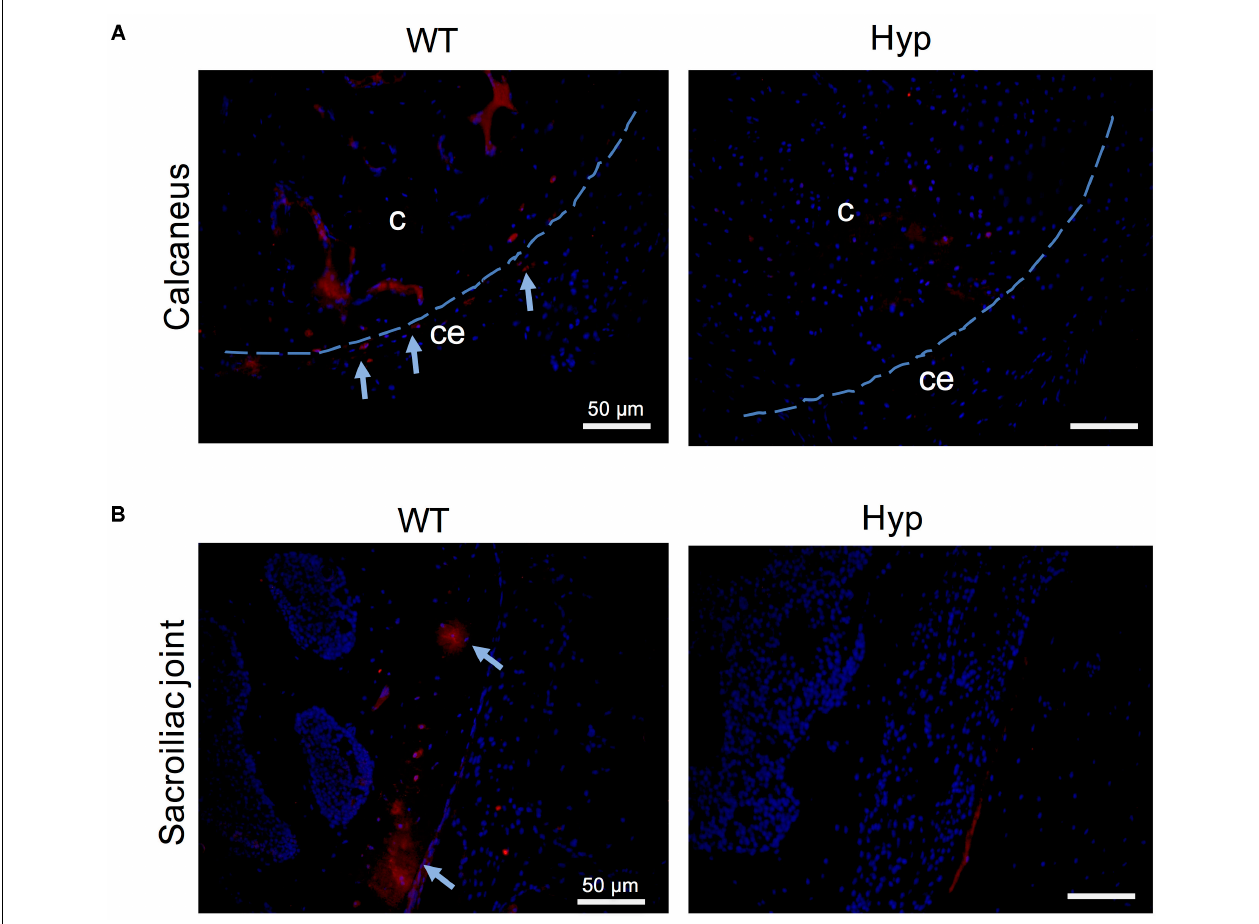
FIGURE 8 | Sclerostin expression in osteoarticular lesions in Hyp mice at M3. In WT mice, sclerostin immunolabeled osteocytes and fibrochondrocytes were observed in the calcaneum (A) and in the cortical bone of the sacroiliac joint (B) (both in the bony part and in the transitional zone between bone and enthesis, indicated with blue arrows). In contrast, very weak expression of sclerostin was seen in these cells in the Hyp calcaneal enthesis and sacroiliac joint. c, calcaneus; ce, calcaneal enthesis (scale bars, 50 µ